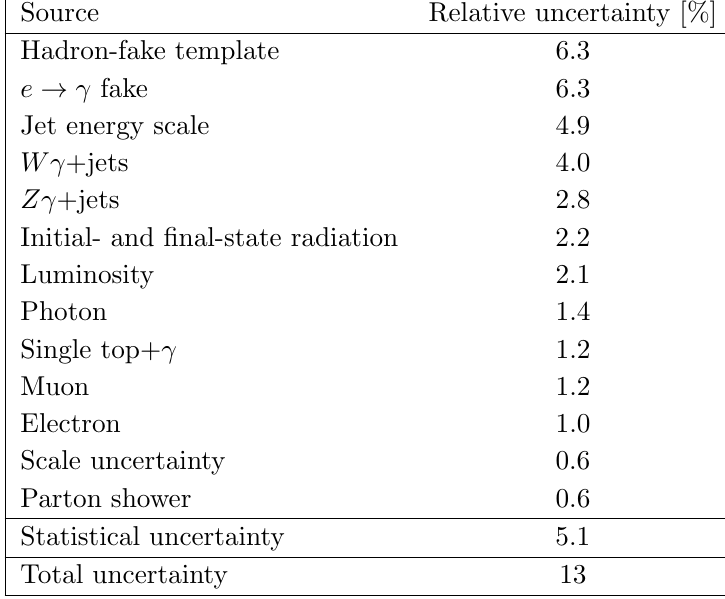
Table 2. List of the most important systematic uncertainties for signal and background and their e(cid:11)ects on the measurement of the inclusive cross section. In addition, the statistical and total uncertainty are given. The total uncertainty is derived from the likelihood (cid:12)t.